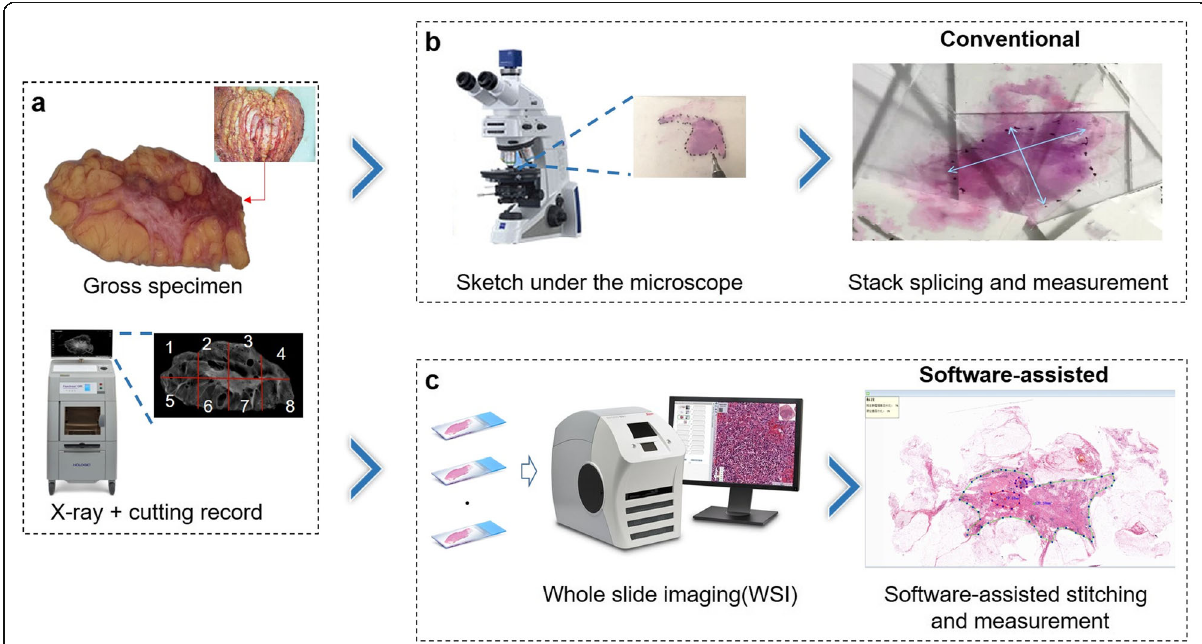
Fig. 2 Flowchart of conventional and software-assisted tumor bed evaluation methods. a Take the regular color image and an X-ray image of the largest residual tumor bed and record the cutting positions. b conventional evaluation method: Draw the edge of the tumor under the microscope, manually stack splice the pathological slides according to the cutting record, and assess the tumor bed. c software-assisted evaluation method : Scan H&E slides to generate WSI images, and then import them into WSI Stitcher for stitching. The software has built-in length and area measurement functions. The percentage of residual tumor cells in the tumor bed and the percentage of carcinoma in situ will be automatically calculated and displayed in the upper left corner once the labeling is